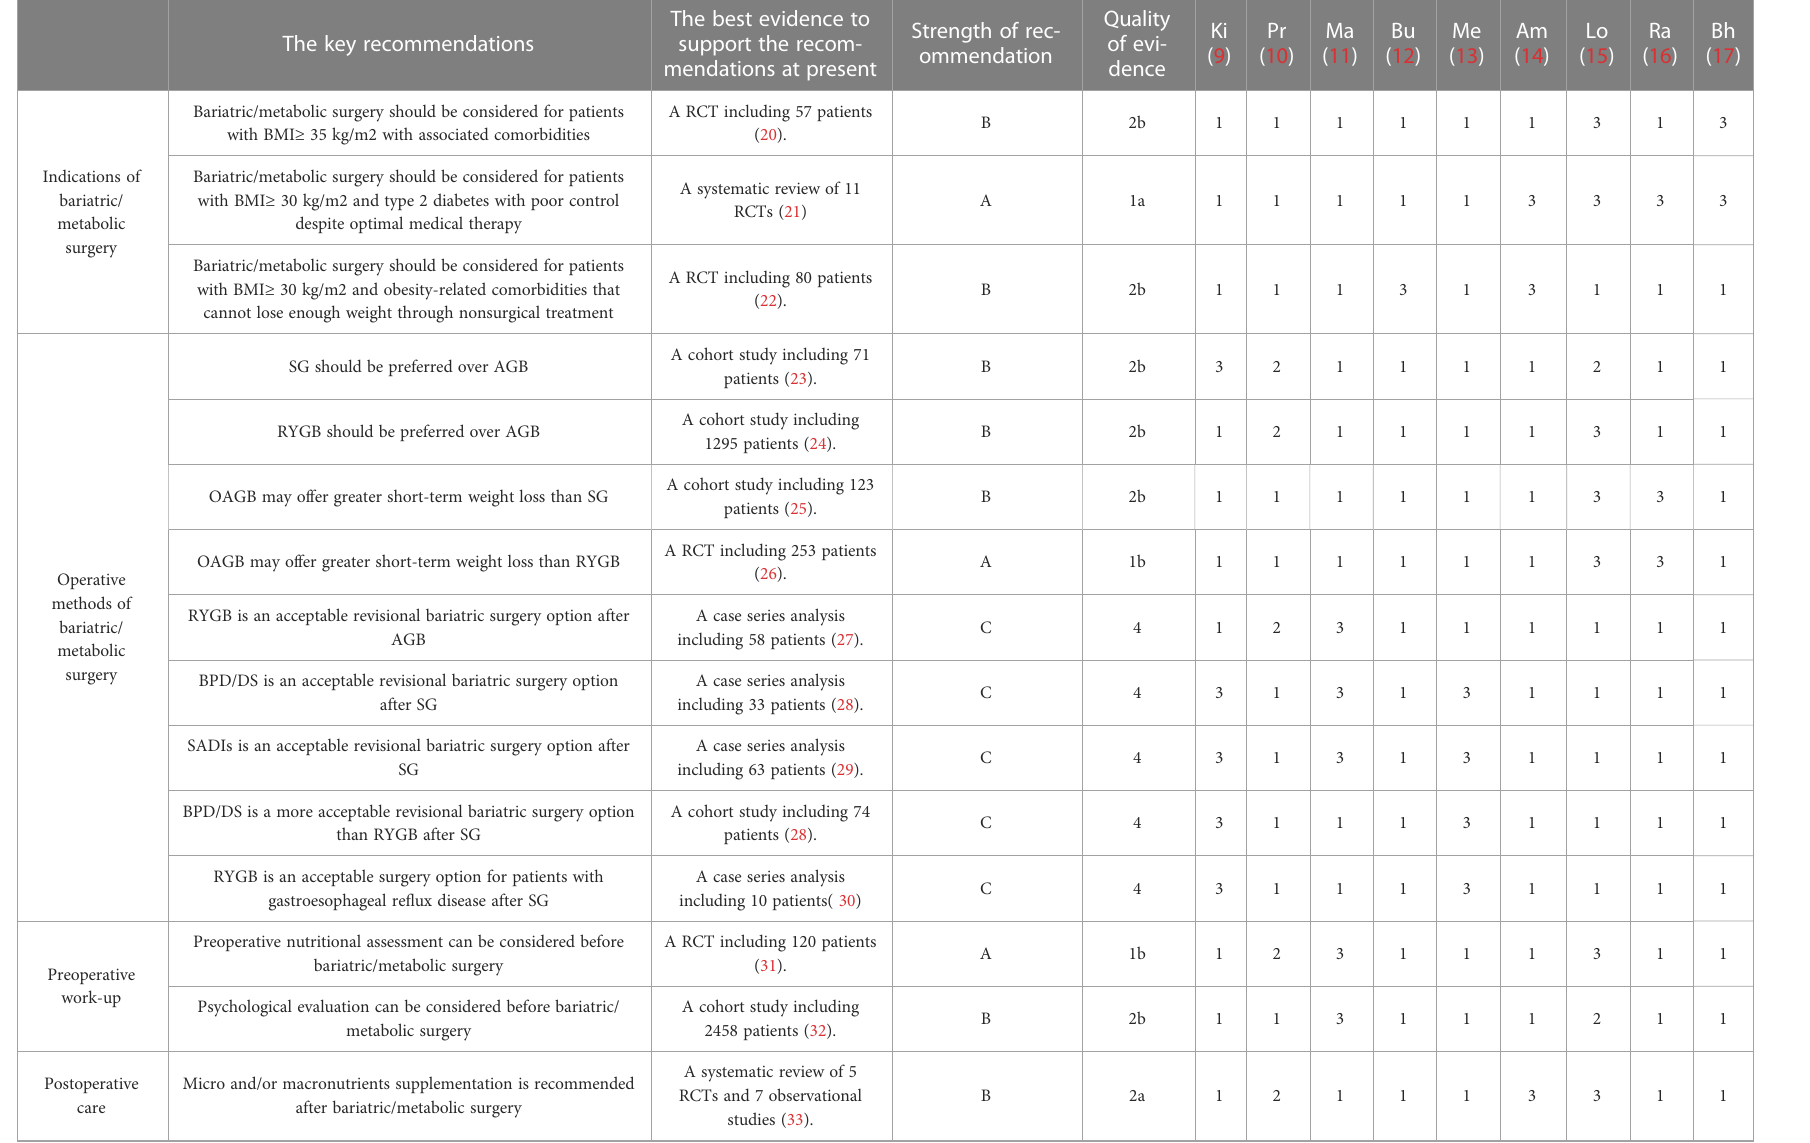
TABLE 3 The key recommendations and the best evidence to support the recommendations at present.